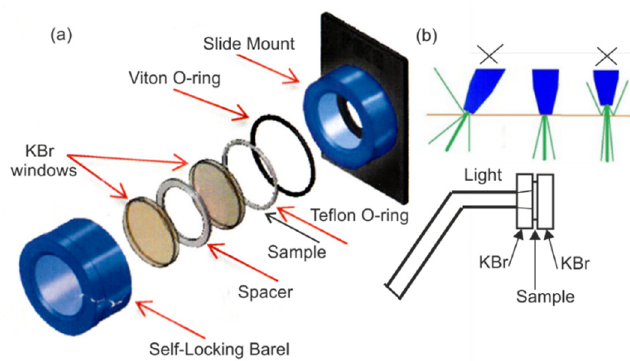
Figure 1. The holder for measuring transmission ( a ). Geometrical arrangement during exposure ( b ). Before and after irradiation of the sample with optical fiber (8 mm diameter), the FTIR spectrum was measured at various times. The average spot of light reaching the monomer after passing through the 3 mm crystal was 9 mm, and this was the diaphragm used in a spectrophotometer.